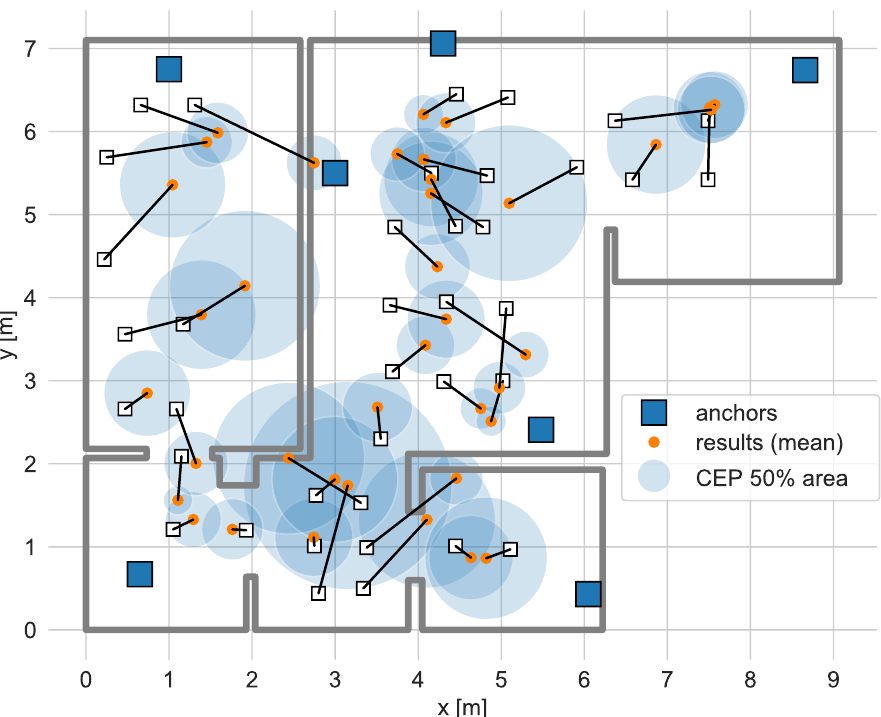
Figure 10. Results of static tag localization using hybrid algorithm with one ultrawideband (UWB) packet transmitted every two seconds.